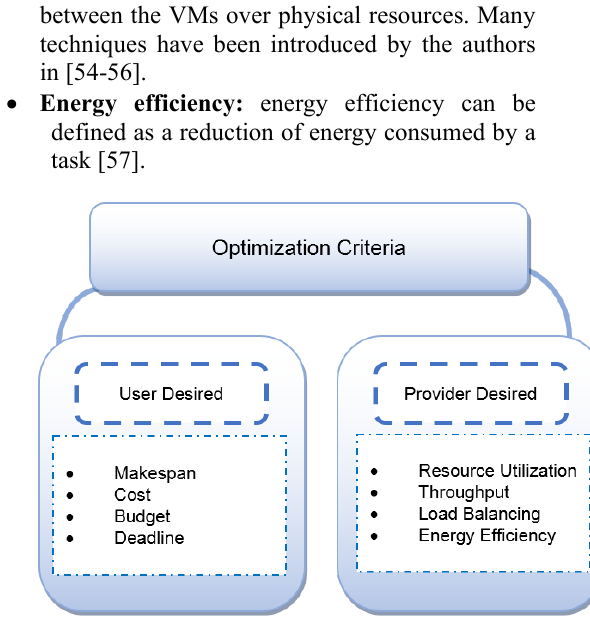
Figure 3. Optimization